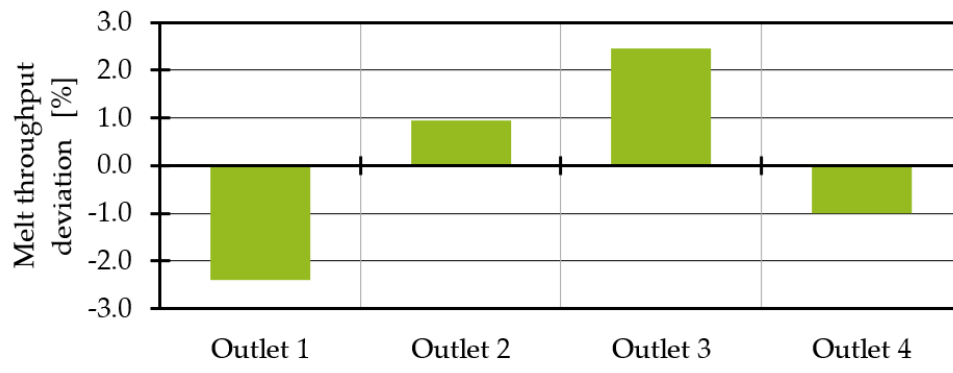
Figure 7. Melt throughput deviation without heat pipes.